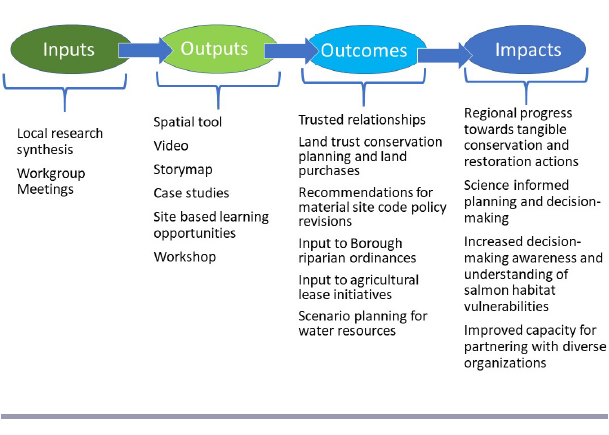
Fig. 6. Malcom Milne, President of the North Pacific Fisheries Association, holds a viewing tank with juvenile coho salmon caught in the headwater stream that he stands beside during a site-based learning opportunity for commercial fishers.